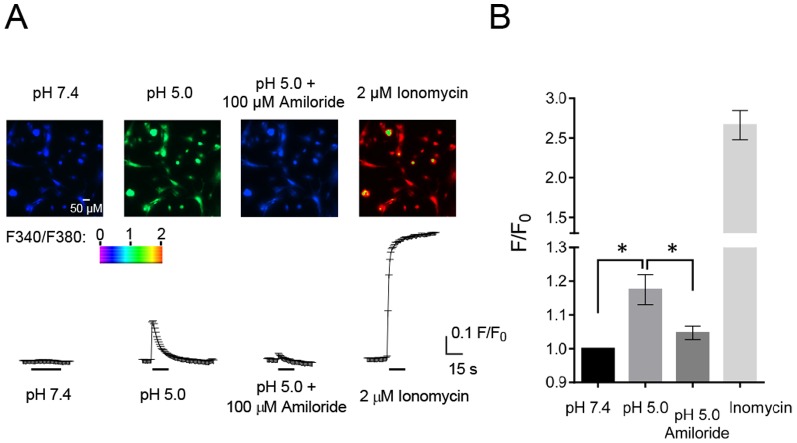
Acid-induced [Ca2+]i increase in cultured anterior pituitary cells.
A. Fluorescence (F340/F380 ratio) was measured under indicated conditions. Top, representative image under indicated conditions. Bottom, average traces of F/F0, (F340/F380)/(F340/F380 at pH 7.4). Applications of 2 µM ionomycin at the end of the recordings served as a positive control (n = 6). B. Average values of F/F0. pH 5.0 increased the F340/F380 ratio to 118±5% compared to the ratio at pH 7.4. Amiloride inhibited the pH 5.0 induced ratio changes (104±2% as baseline), n = 6. * P<0.05, one-way ANOVA with Tukey's post-hoc multiple comparison test.